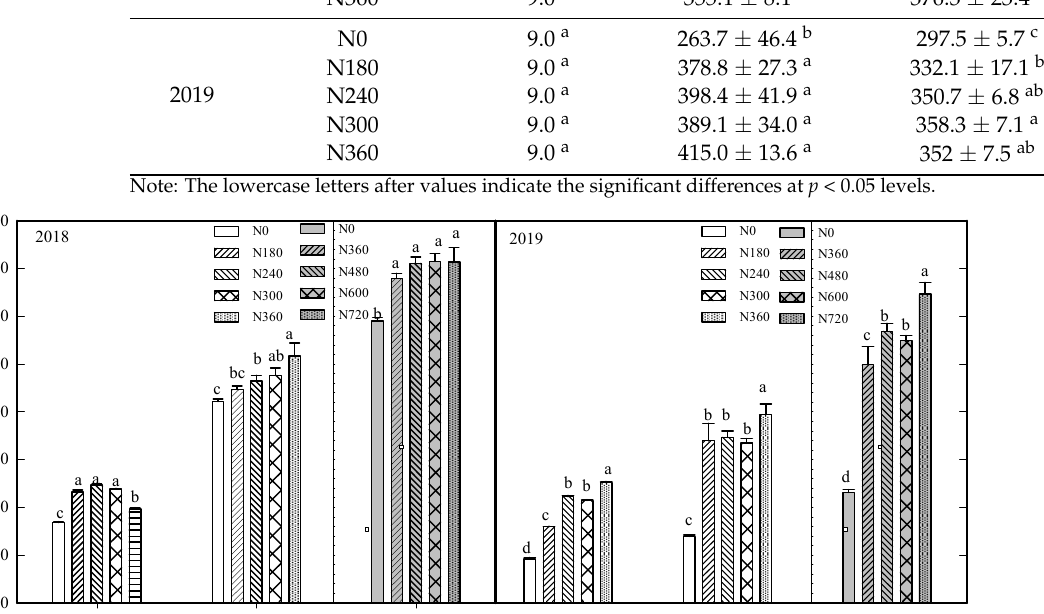
( B ) Figure 4. Effects of the nitrogen application rate on the spring wheat (A) and summer maize (B) maximum leaf area index at the flowering or silking stage. Note: The lowercase letters above bar graph indicate the significant differences at p < 0.05 levels. Similar to spring wheat, the summer maize LAImax increased significantly by 11.1– 25.4% and 41.5–76.8% with the increase in the N application rate compared to the N 0 treat- ment in 2018 and 2019, respectively (Figure 4B). Additionally, the LAImax under the N 180 treatment was significantly decreased compared to that of the N 300 and N 360 treatments